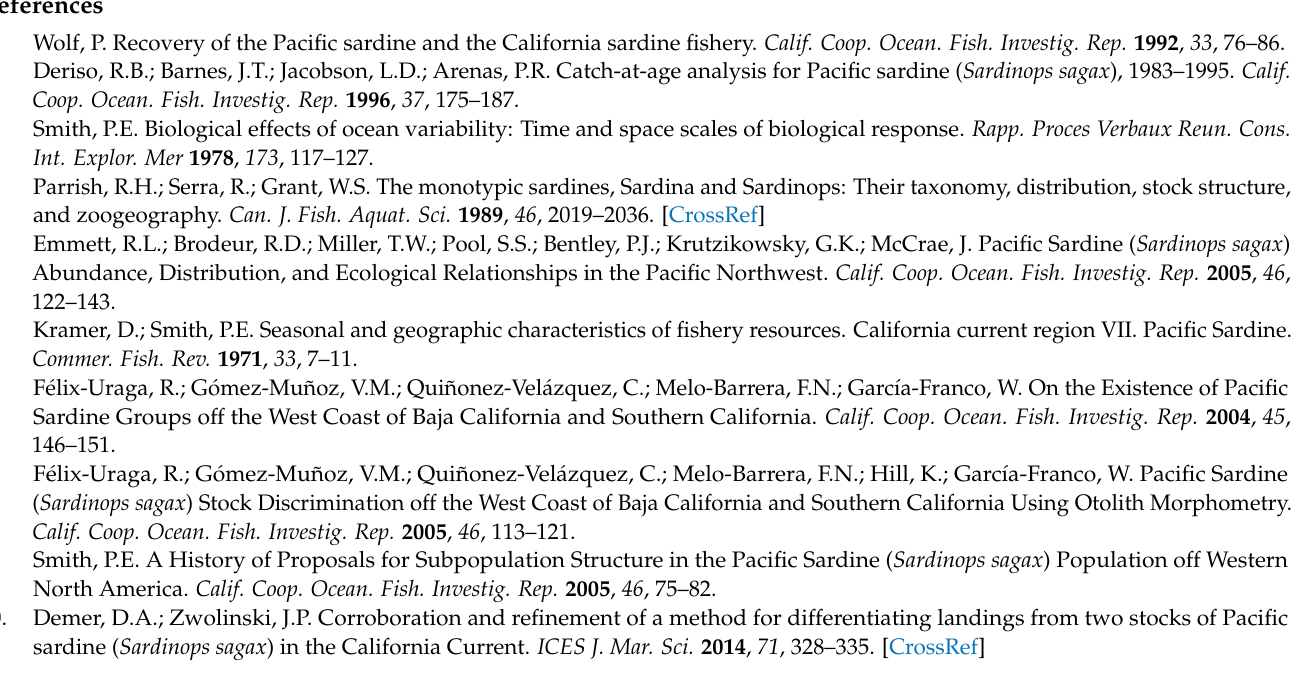
Figure S2. Age frequency distribution by year the temperate Sardinops sagax stock in the southern of California Current System (CCS); Figure S3. Growth models adjusted to age-at-length raw data of the temperate Sardinops sagax stock in the southern California Current System (CCS) during the study period (2005–2014); Table S1. Values and 95% confidence intervals (CI; α = 0.05) of parameters a and b obtained by adjusting, to raw TM–SL data bolstered by simulated values, the potential model for each year from 2005 to 2014 of the temperate Sardinops sagax stock and growth type (GT; +H, hyper-allometry; − H,